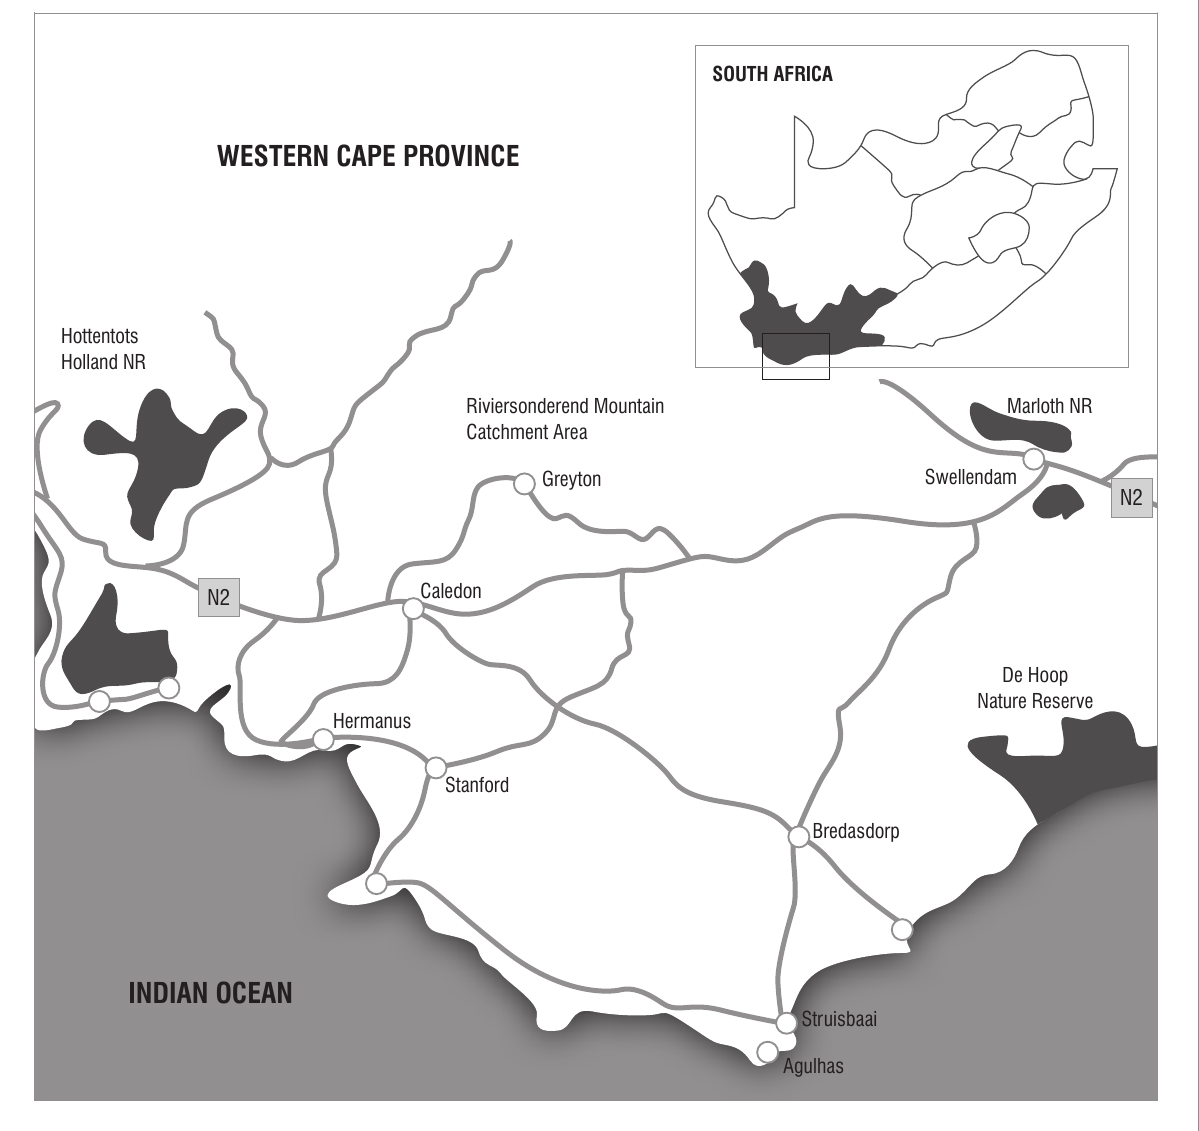
Figure 1: A map showing the study